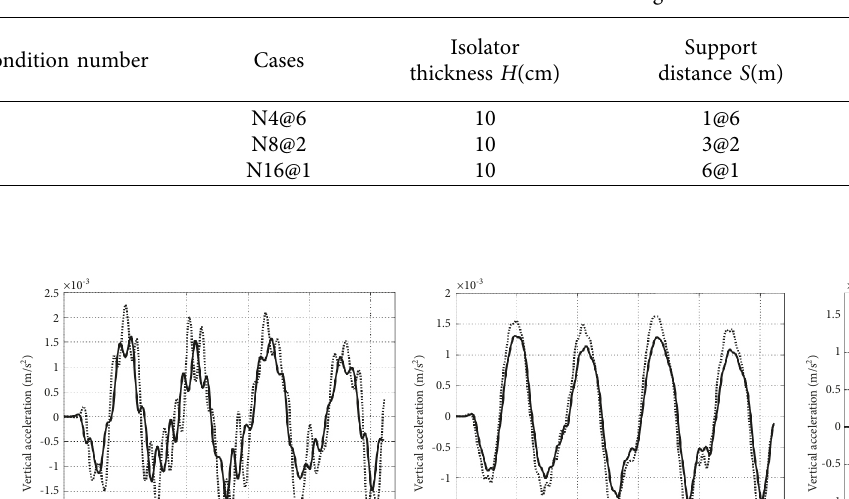
Table 4: Number of vibration legislators conditions.